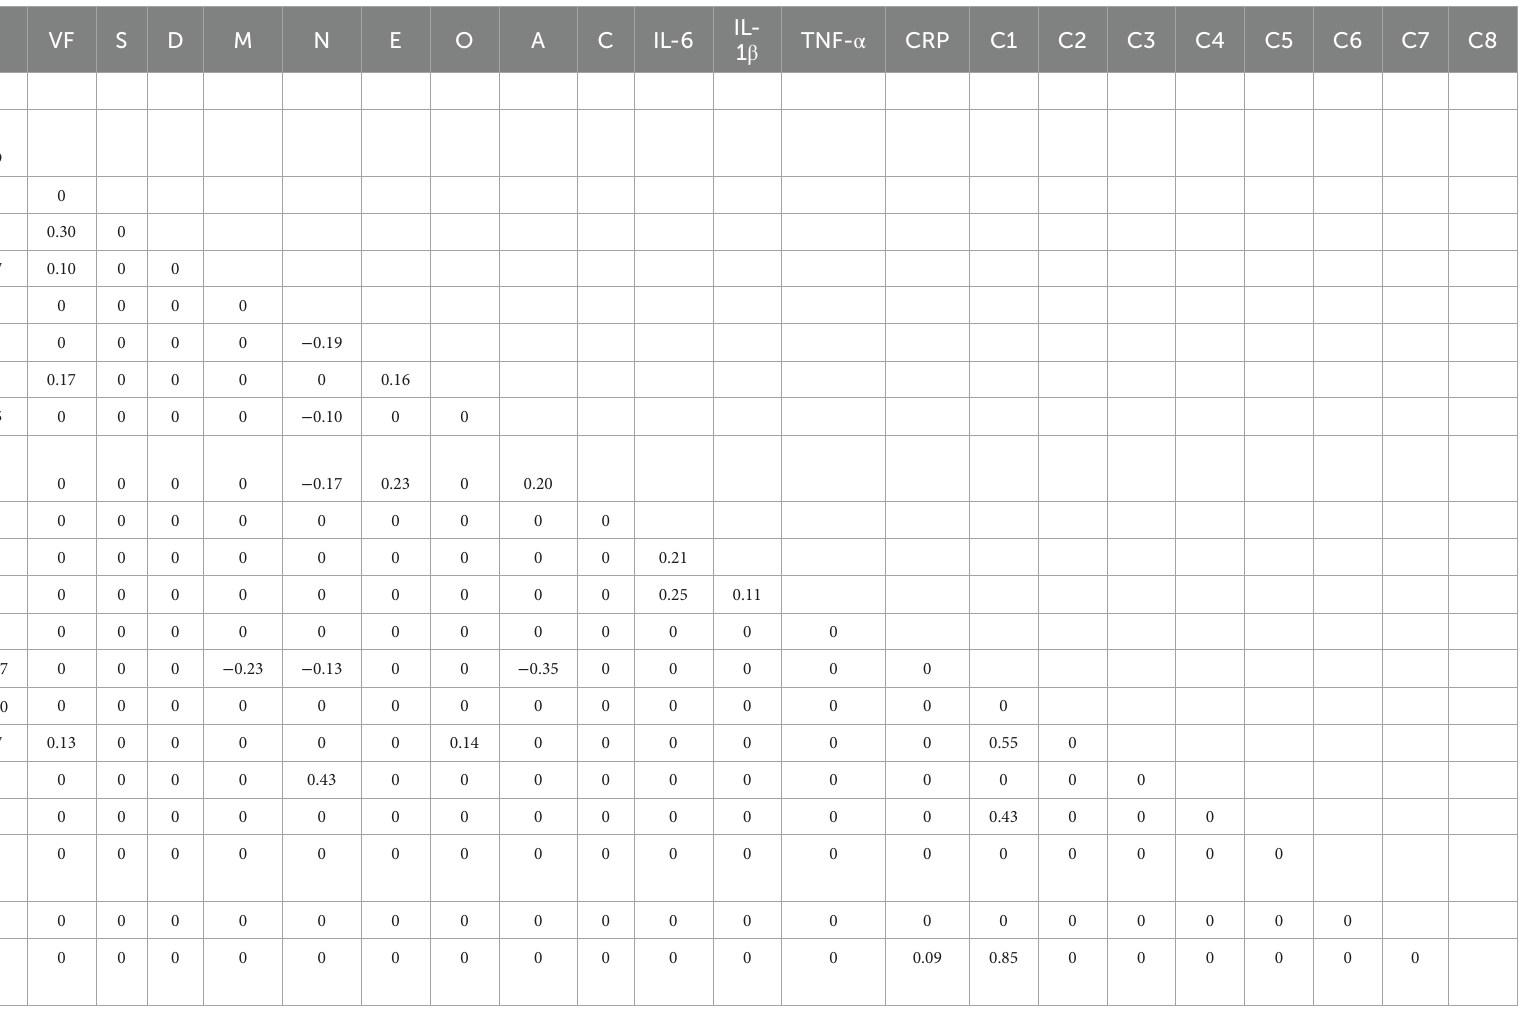
TABLE 4 Partial correlations matrix of network B (cognition, personality, inflammatory markers, and